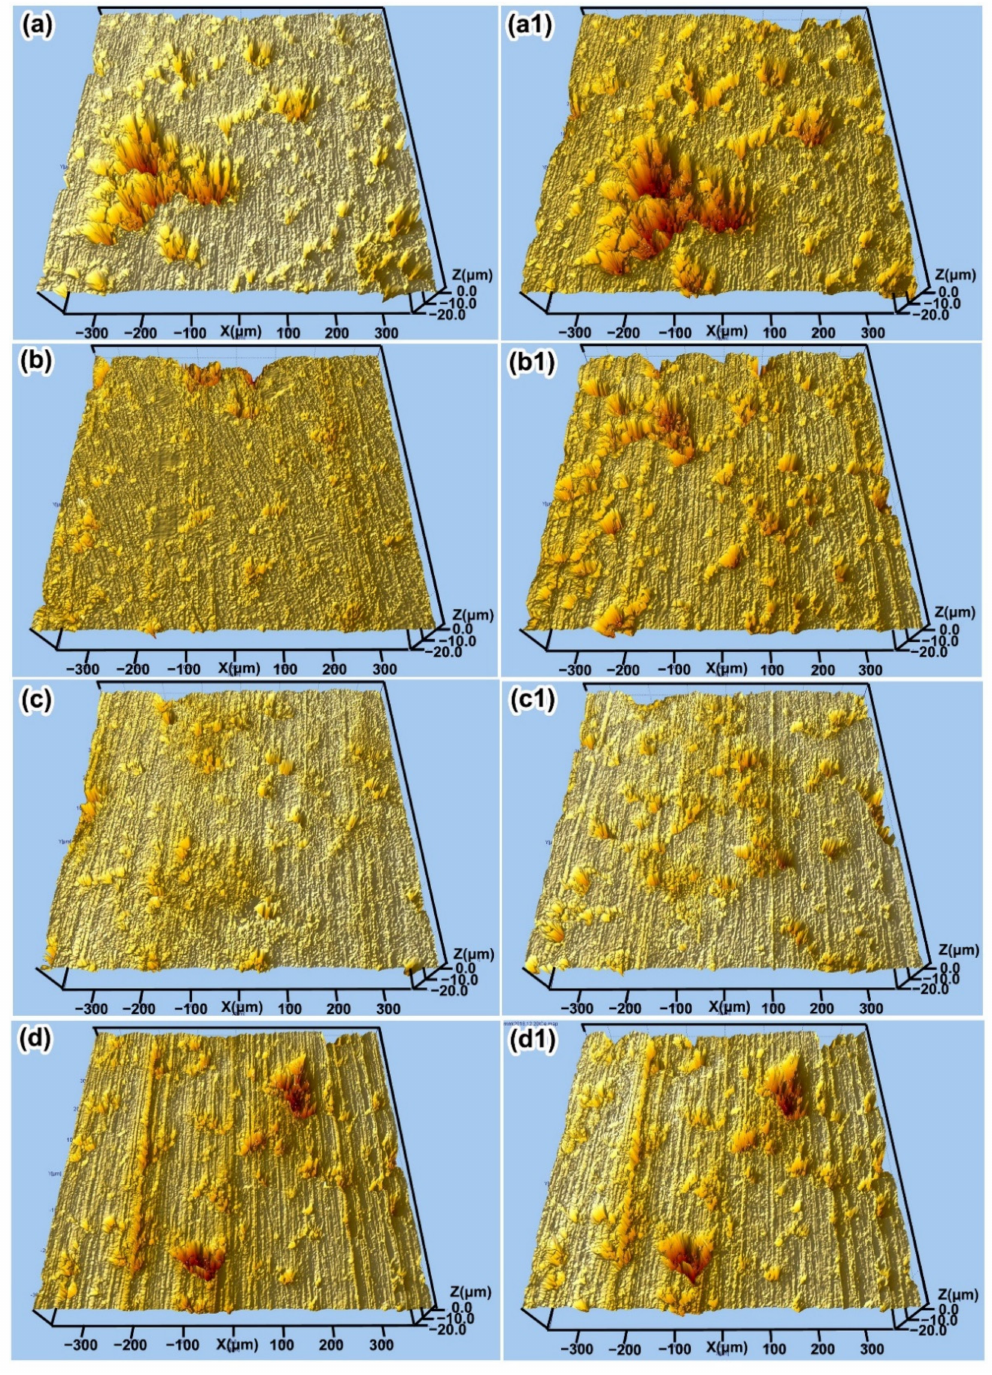
Figure 6. Three-dimensional surface roughness of ( a , a1 ) as-sprayed AMC, ( b , b1 ) SAS coating, ( c , c1 ) APS coating and ( d , d1 ) CSS coating ( a – d ) before and ( a1 – d1 ) after erosion–corrosion tests for 12 h by 3.5 wt.% NaCl solution containing 2 wt.%